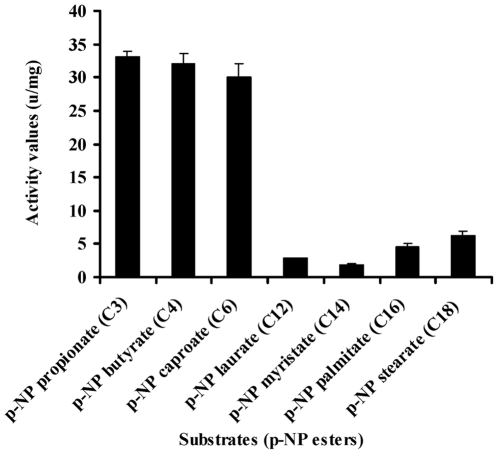
Esterase activity of MEST1 is highest in the presence of short-chain esters (C4–C8).Substrate specificity of MEST1 was determined by hydrolysis of p-nitrophenyl esters with different carbon chain lengths. The activity values are reported as means ± standard errors from three independent assays using crude cell extracts of E. coli Rosetta (DE3) expressing MEST1 as compared to extracts from E. coli transformed with the corresponding empty vector.